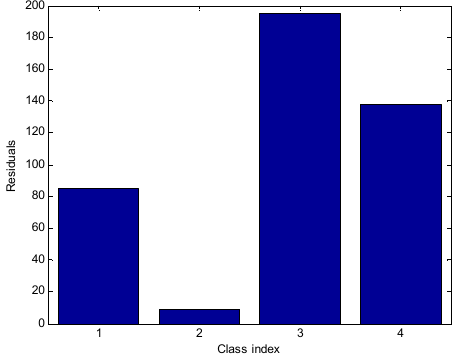
Figure 5. Residuals between the original sample and reconstructed samples.